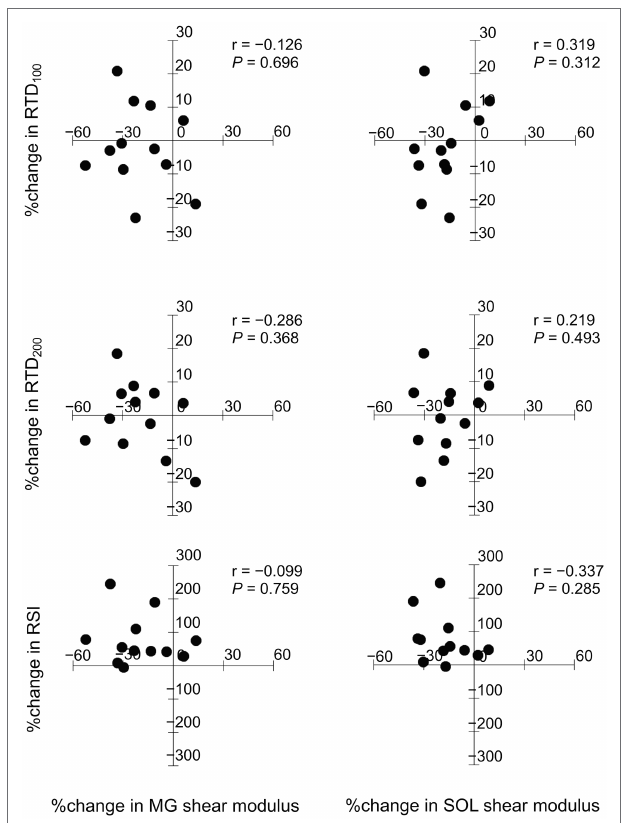
FIGURE 2 | Relationships between the relative changes in shear moduli of the medial gastrocnemius (MG) and soleus (SOL) with rate of torque development (RTD 100 , RTD 200 ), and reactive strength index